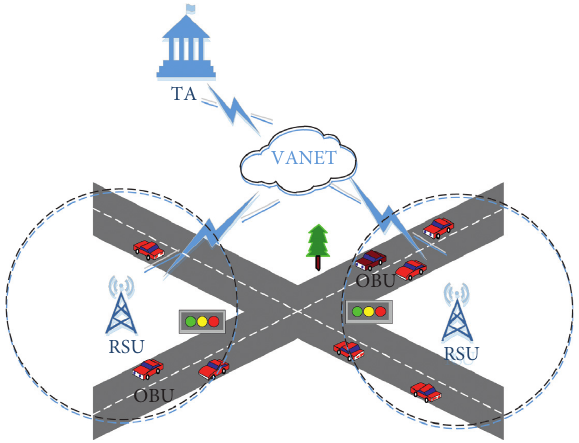
Figure 1: The system model of